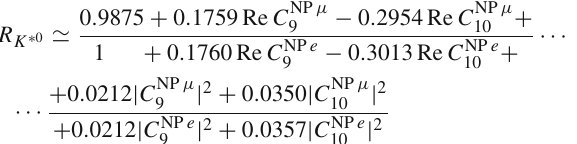
, using a imaginary and b real Wilson 5